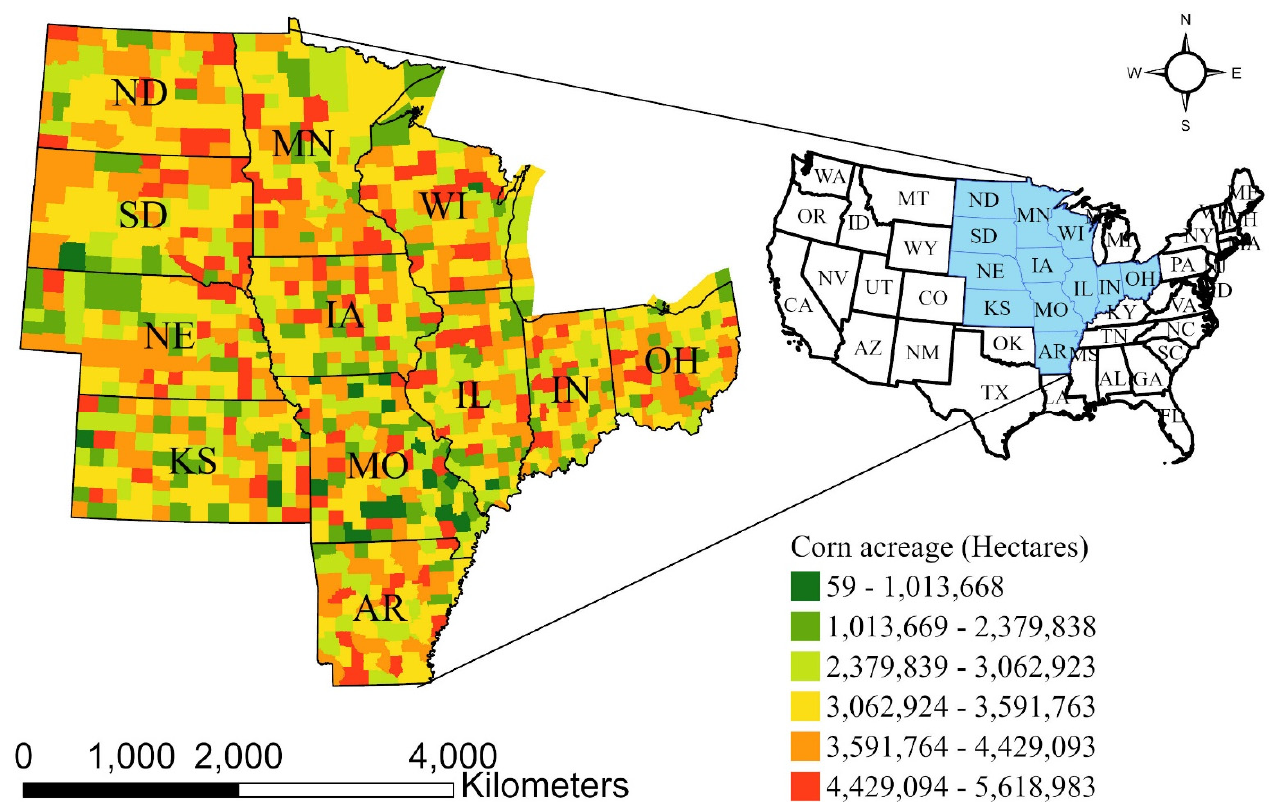
Figure 1. The map of the study area (Corn acreage by county in 2020).